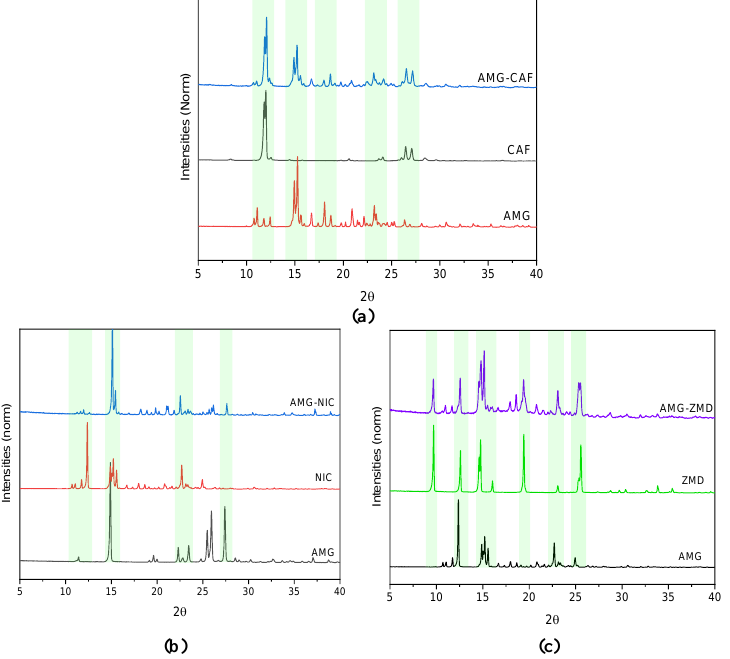
Figure 2. Overlay of PXRD patterns of ( a ) AMG, CAF and the eutectic mixture of the AMG-CAF system, ( b ) AMG, NIC and the eutectic mixture of the AMG-NIC system and ( c ) AMG, ZMD and the eutectic mixture of the AMG-AMD system. Main characteristic peaks are indicated by dashes lines. In a eutectic system, the retention of the crystal structure of individual components is expected, consequently, the PXRD pattern of the eutectic system should contain the overlap of diffraction peaks of starting components without the generation of new diffrac- tion peaks. As seen in the comparison of the diffraction patterns of the eutectic mixtures and the pure starting components, no new peaks were observed and all the diffraction peaks of the starting components are present in the grinded mixtures, signifying the for- mation of eutectic mixtures in all three studied cases. Differential Scanning Calorimetry (DSC) Analysis DSC is one essential technique to characterize the solid phase behavior of a material and mixtures. It is crucial to detect the eutectic nature of a multicomponent system as typically the melting point of the eutectic mixture is lower than either of the parent com- ponents and the eutectic melting can be identified via the melting events occurring. The DSC patterns of the various AMG-coformer mixtures overlayed with those of the pure components are shown in Figure 3, specifically for the AMG-CAF system in Figure 3a, the AMG-NIC system in Figure 3b and the AMG-ZMD system in Figure 3c.